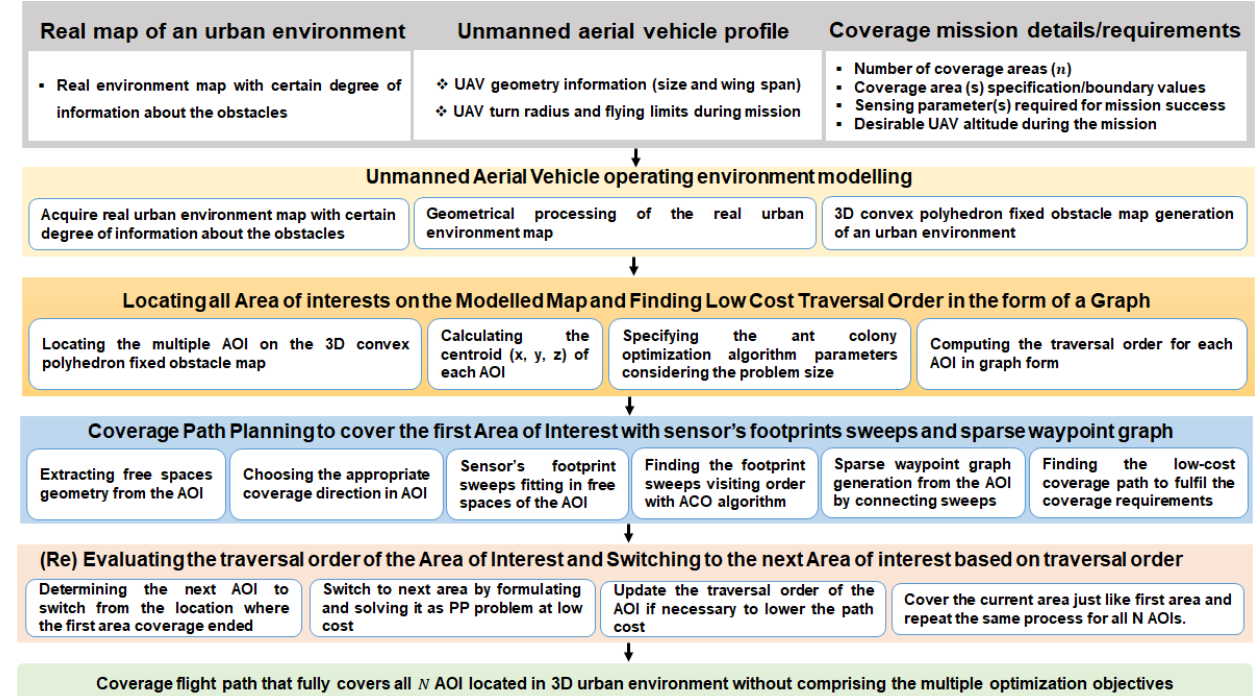
Figure 4. Conceptual overview of the proposed multi-objective coverage flight path planning